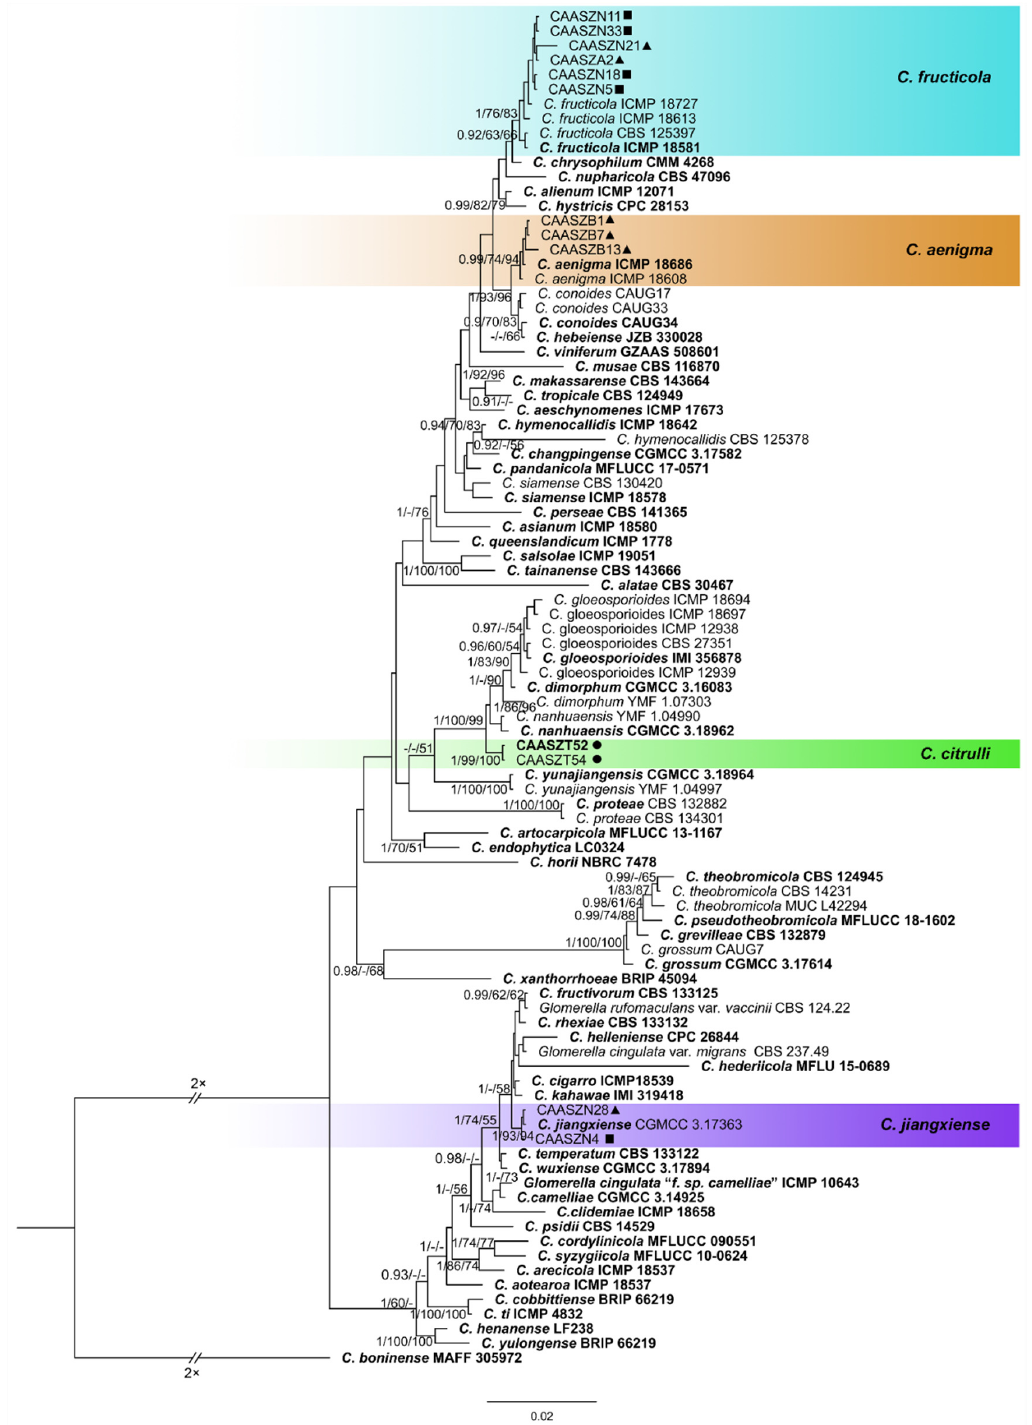
Figure 2. A Bayesian inference phylogenetic tree of 92 isolates in the C. gloeosporioides species complex. The species C. boninense (MAFF 305972) was selected as an outgroup. The tree was built using concatenated sequences of the ITS, gadph , chs-1 , his3 , act , and tub2 genes. Bayesian posterior probability (PP ≥ 0.90), MP bootstrap support values (MP ≥ 60%), and iqtree bootstrap support values (ML ≥ 50%) were shown at the nodes (PP/MP/ML). Ex-type isolates are in bold. Colored blocks indicate clades containing isolates from Citrullus lanatus in this study; triangles indicate strains isolated from leaves, rectangle indicate strains isolated from stems, circles indicate strains isolated from fruits. The scale bar indicates 0.02 expected changes per site.